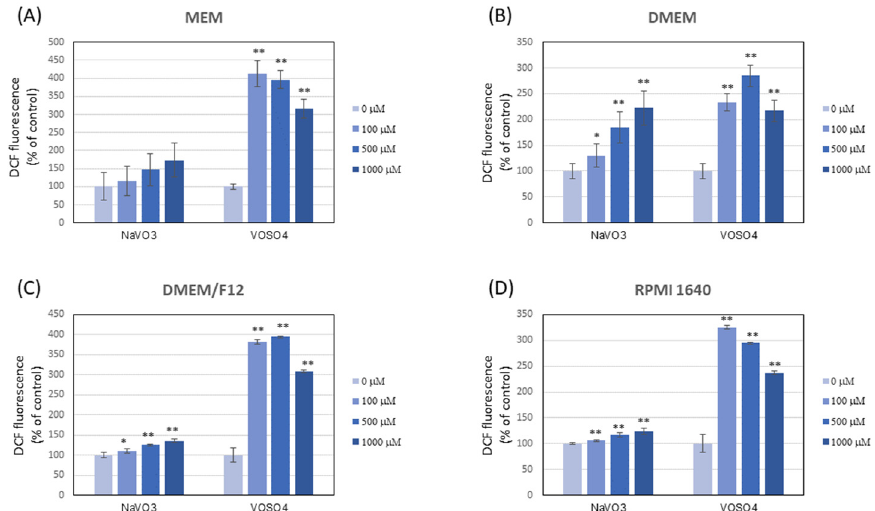
Figure 2 . Oxidation of 2 ′ ,7 ′ -dichlorodihydrofluorescein diacetate (DCFH-DA) to fluorescent dichlorofluorescein (DCF) in culture media after the addition of VOSO 4 or NaVO 3 . The cell-free culture media were exposed to VOSO 4 or NaVO 3 (final concentrations of 100, 500, and 1000 µM) followed by the addition of the DCFH-DA probe (final concentration of 10 µM) and incubated for 15 min at 37 °C: ( A ) MEM; ( B ) DMEM; ( C ) DMEM/F12; ( D ) RPMI. The data are presented as means with error bars representing standard deviation. The data are representative of at least two independent experiments. Statistical differences between the control and the V-exposed media: * p < 0.05, ** p < 0.001 (one-way ANOVA followed by Dunnett’s T3 test).